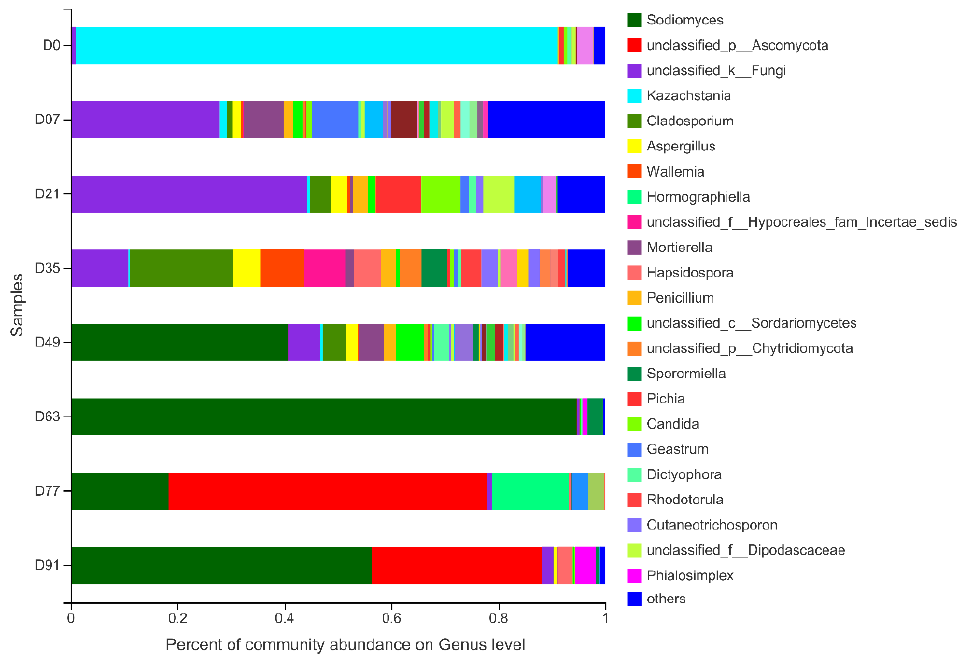
Figure 2. Genus levels composition of the fungal community during the composting process.